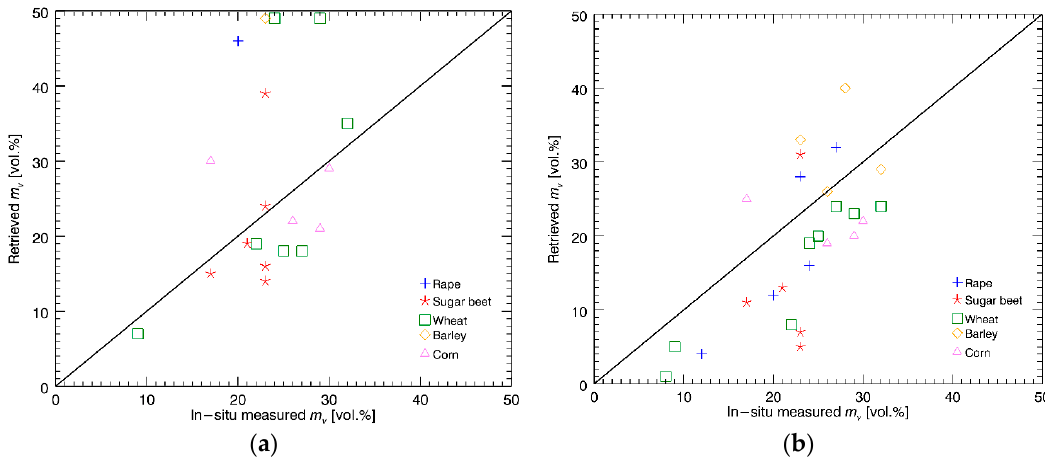
Figure 13. Scatterplot of the retrieval results vs. measured ground truth: ( a ) co-pol/correlation method; ( b ) modified co-pol/correlation method.